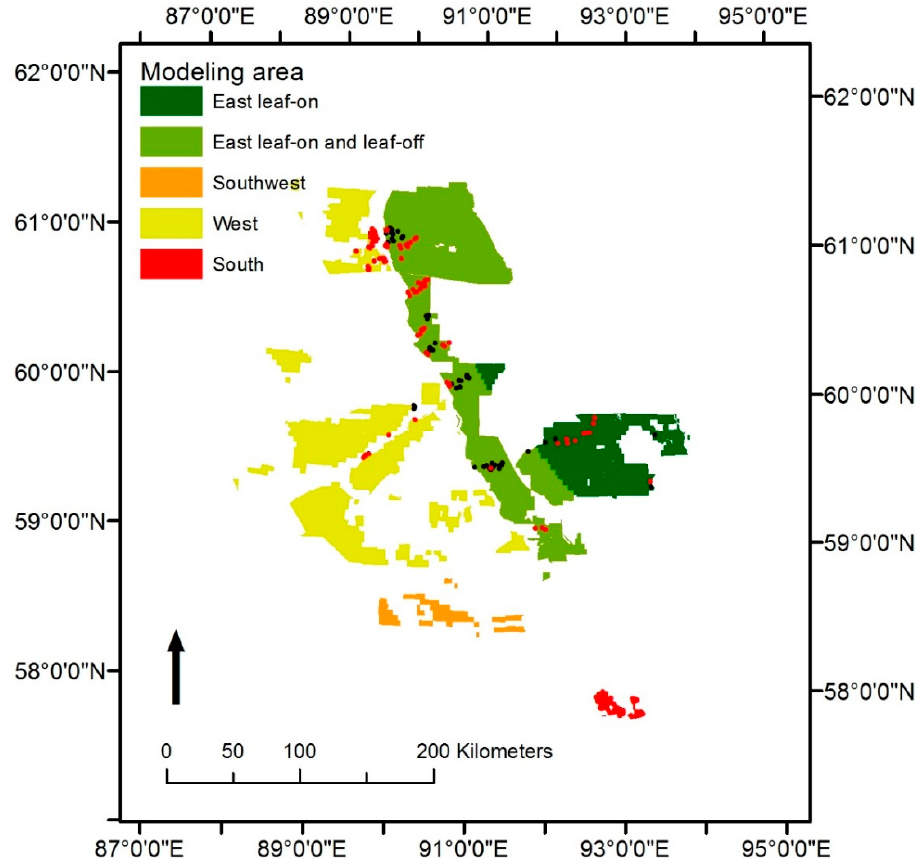
Figure 7. Modeling areas and locations of measured field sample plots (red), and locations of not measured plots of the final sample (black). Note that the symbols of the measured sample plots cover the modeling area South at the image scale.